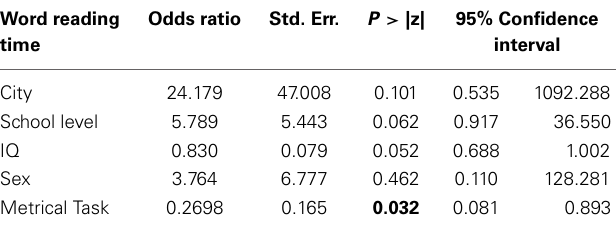
Table 8 | Logistic